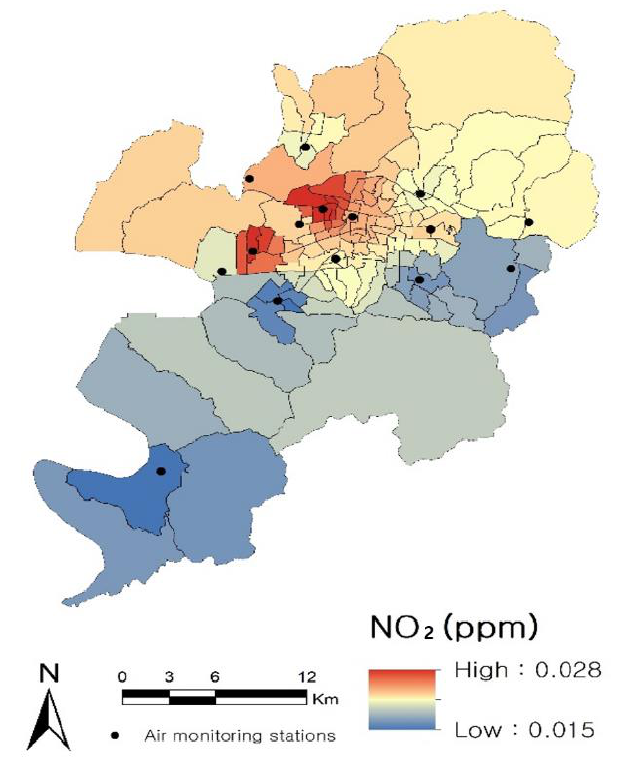
Figure 4. Spatial distribution of NO 2.